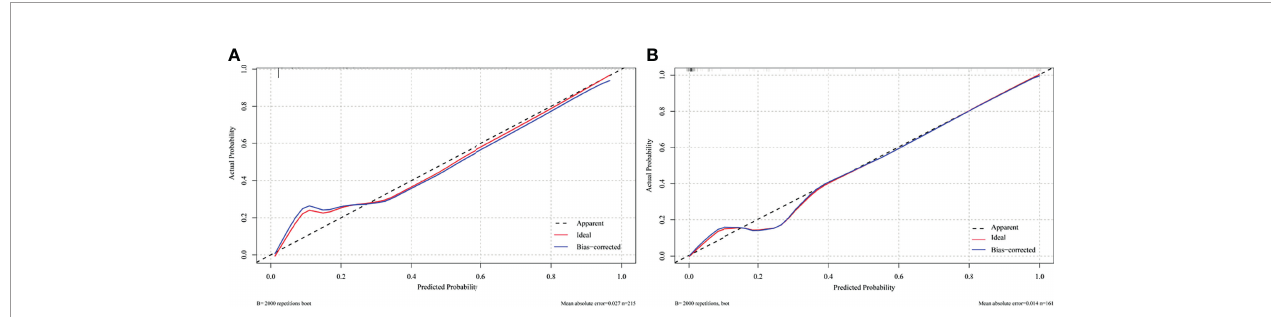
FIGURE 4 | Calibration plot comparing predicted and actual probability of lymph node metastasis in (A) training cohort ( n = 215) and (B) validation cohort ( n =